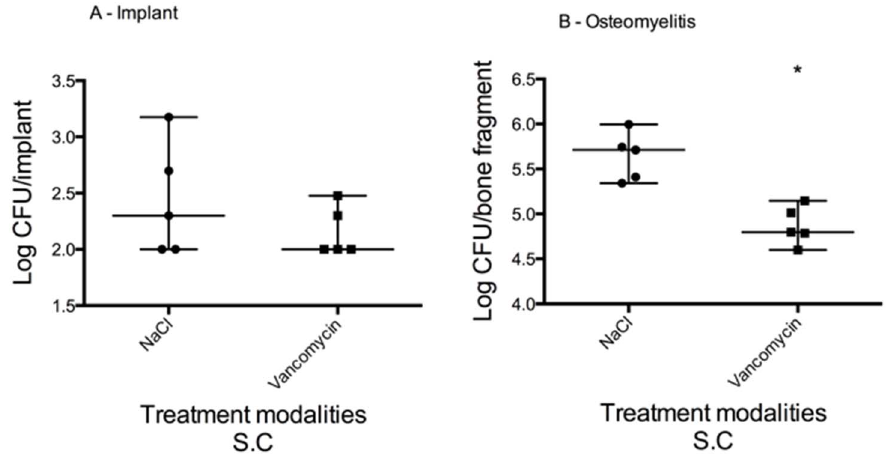
Figure 7. Vancomycin treatment effect on biofilm on implant and osteomyelitis, median and range (logarithmic scale). On day 12 post surgery, vancomycin treatment (180 mg/kg S.C q12) was started. Treatment duration was 14 days. Treatment outcome was evaluated on both implant samples (a) and tibia samples (b). The vancomycin was unable to eradicate the biofilm formed on the surface of the implant, yet it did have an effect on the osteomyelitis. Bacterial load was reduced from 5.7 (range: 5.4–5.9) log CFU/bone fragment to 4.8 (range: 4.6–5.1) log CFU/bone fragment (Mann-Whitney, P=0.0079).